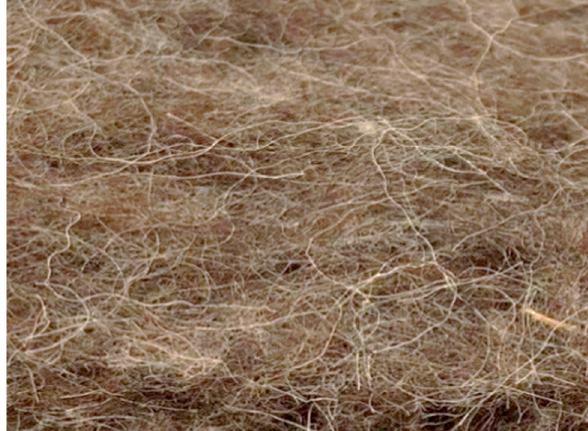
Figure 1. The raw material used: black merino sheep wool.